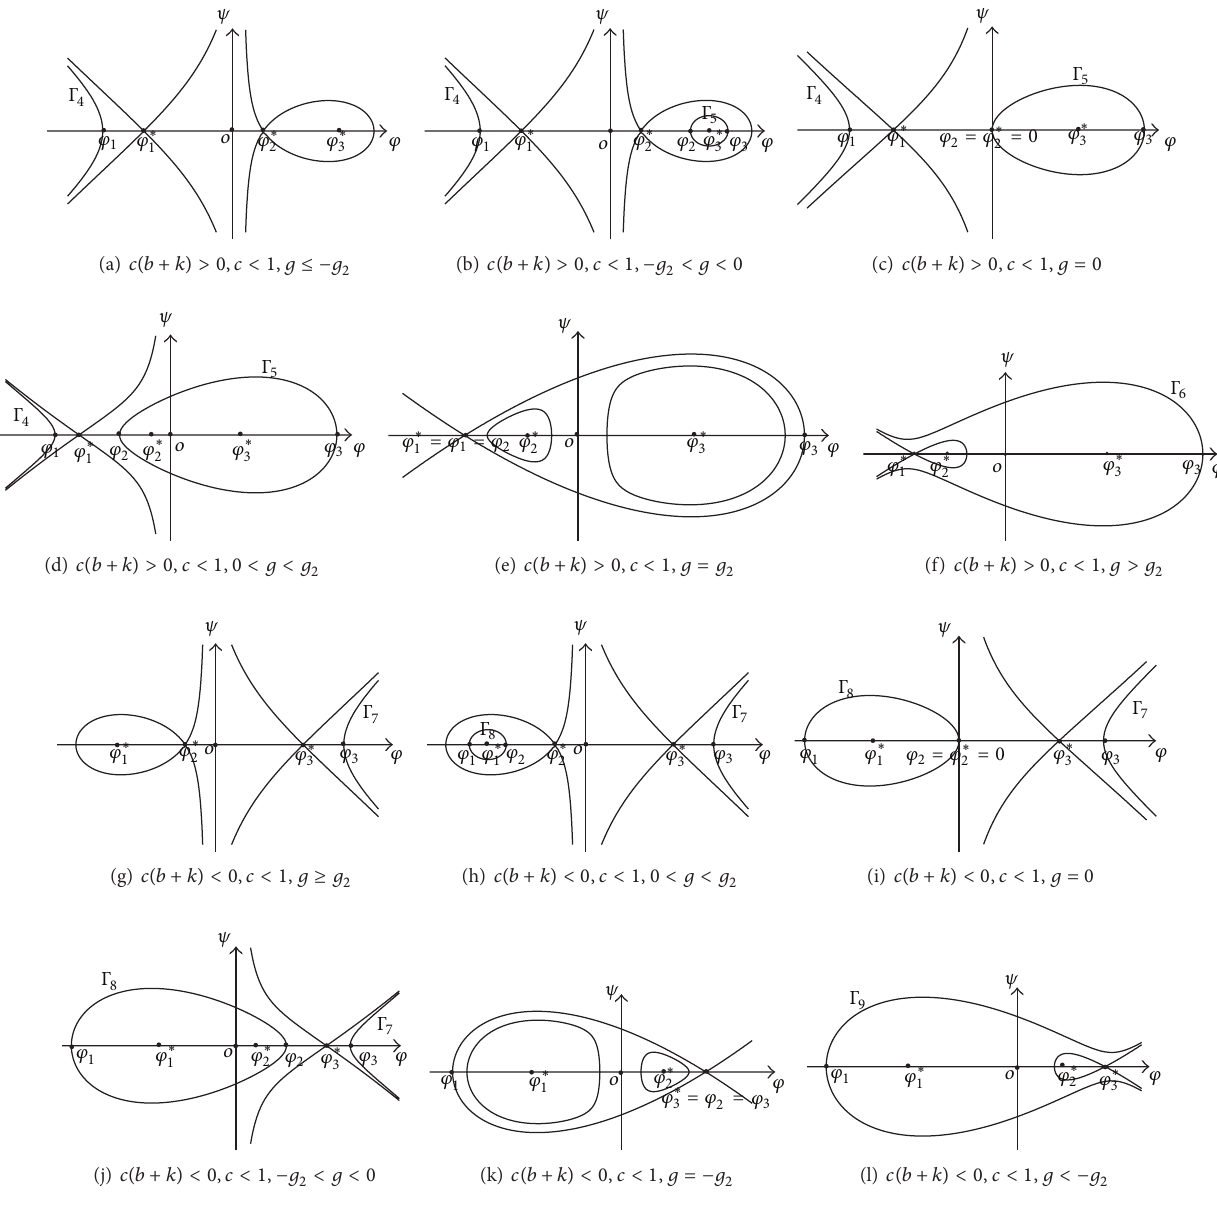
Figure 6: The phase portraits of system